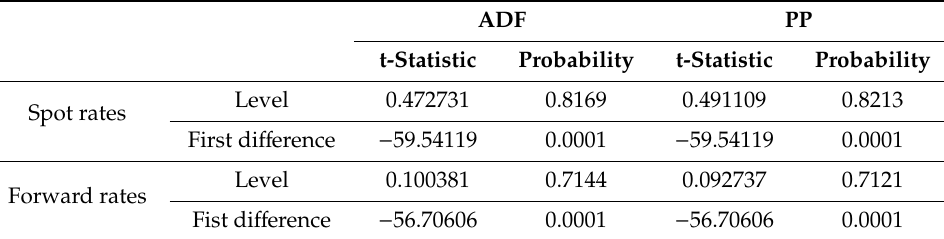
Table 5. Unit root test for stationarity of the